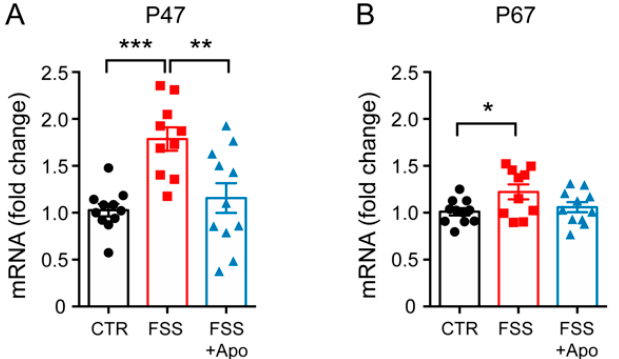
Figure 3. Apocynin prevents the FSS ‐ induced increase of p47phox expression. ( A , B ) mRNA levels of p47phox ( A ) and p67phox ( B ) measured in the hippocampus (HPC). One ‐ way ANOVA followed by Tukey’s post hoc analysis. Data are presented as mean ± SEM ( n = 10–11 mice/group). * p < 0.05; ** p < 0.01; *** p < 0.001.